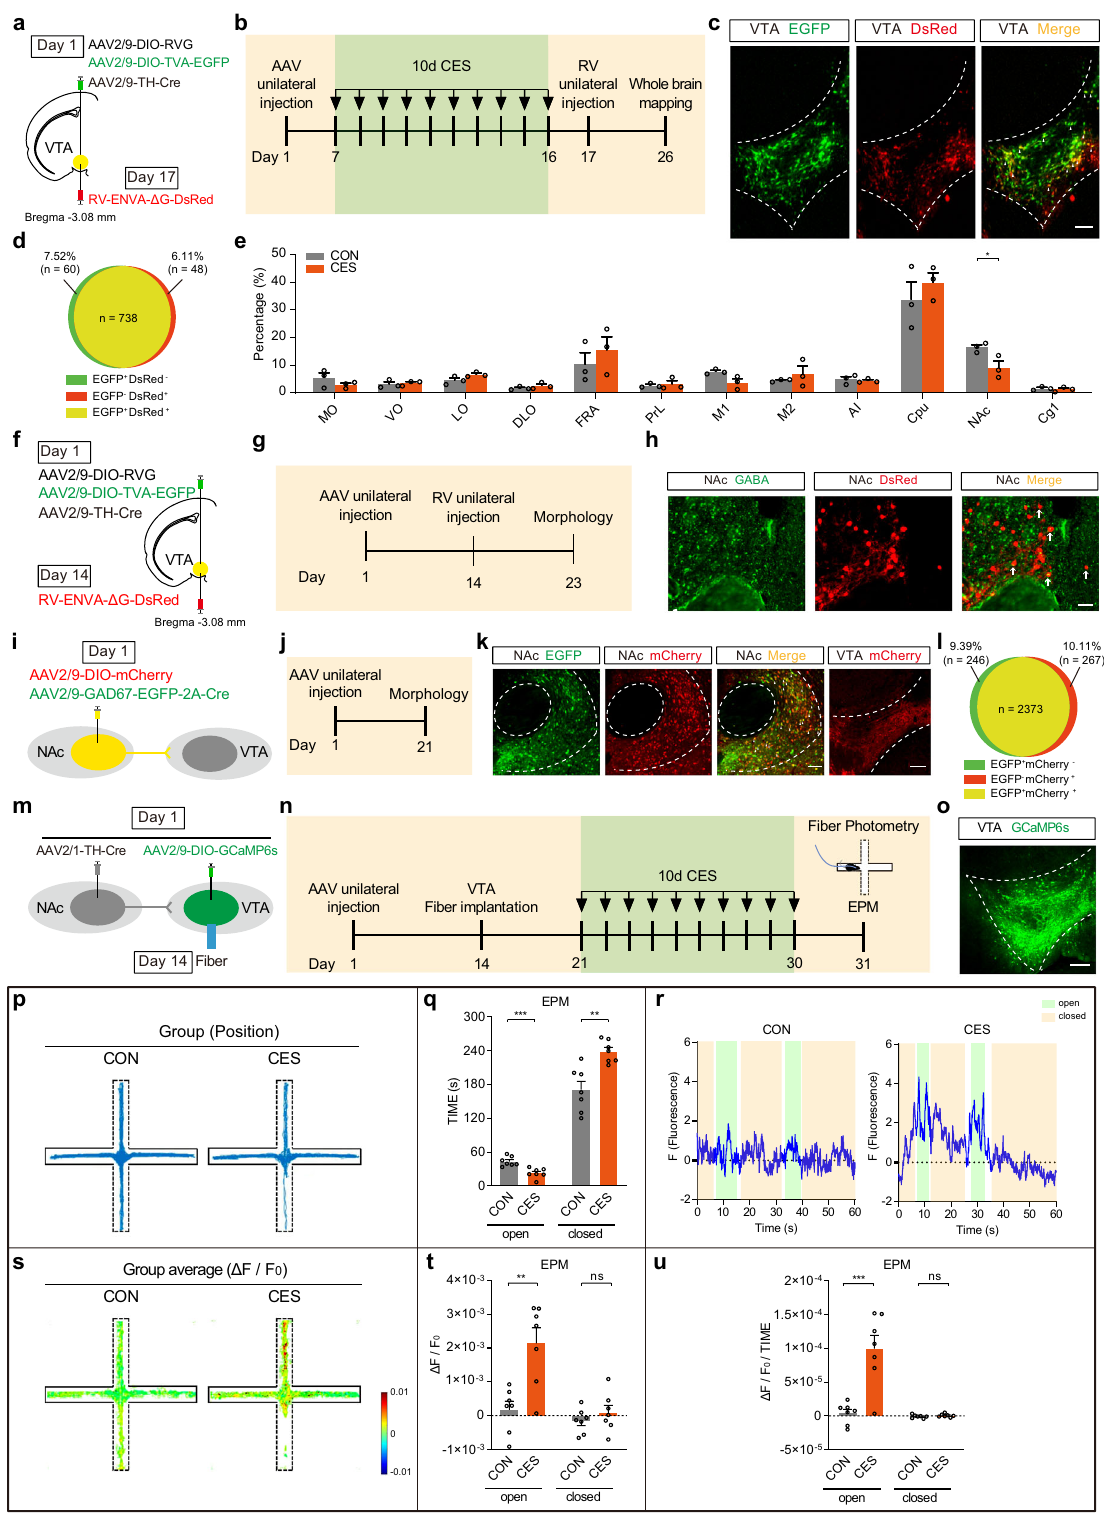
Methods behavioral testing room for at least 1hour before testing. All procedures were approved Animals . C57BL/6J mice (6 – 8 weeks, male) and CD1 mice (30 – 35 weeks, male) were by the Animal Care Committee at Huazhong University of Science and Technology and performed in accordance with the Institutional Animal Welfare Guidelines. purchased from Beijing Vital River Laboratory Animal Technology Co., Ltd. Adult male DAT-Cre mice (No. NM-KI-200092, 8 – 10 weeks) were purchased from Shanghai Model Organisms Center, Inc. All mice were housed under stable temperature Virus preparations . We used the following virus vectors carrying the following (22 – 25°C) and consistent humidity (50±5%) in a 12-hour light/dark cycle. Mice were speci fi c genes purchased from BrainVTA (Wuhan): AAV2/9-hSyn-DIO- group-housed for 1 week prior to the experiment and allowed to acclimate to the GCaMP6s-WPRE-pA, AAV2/9-TH-NLS-Cre-WPRE-pA, AAV2/9-Ef1 α -DIO- NATURE COMMUNICATIONS| (2022) 13:577